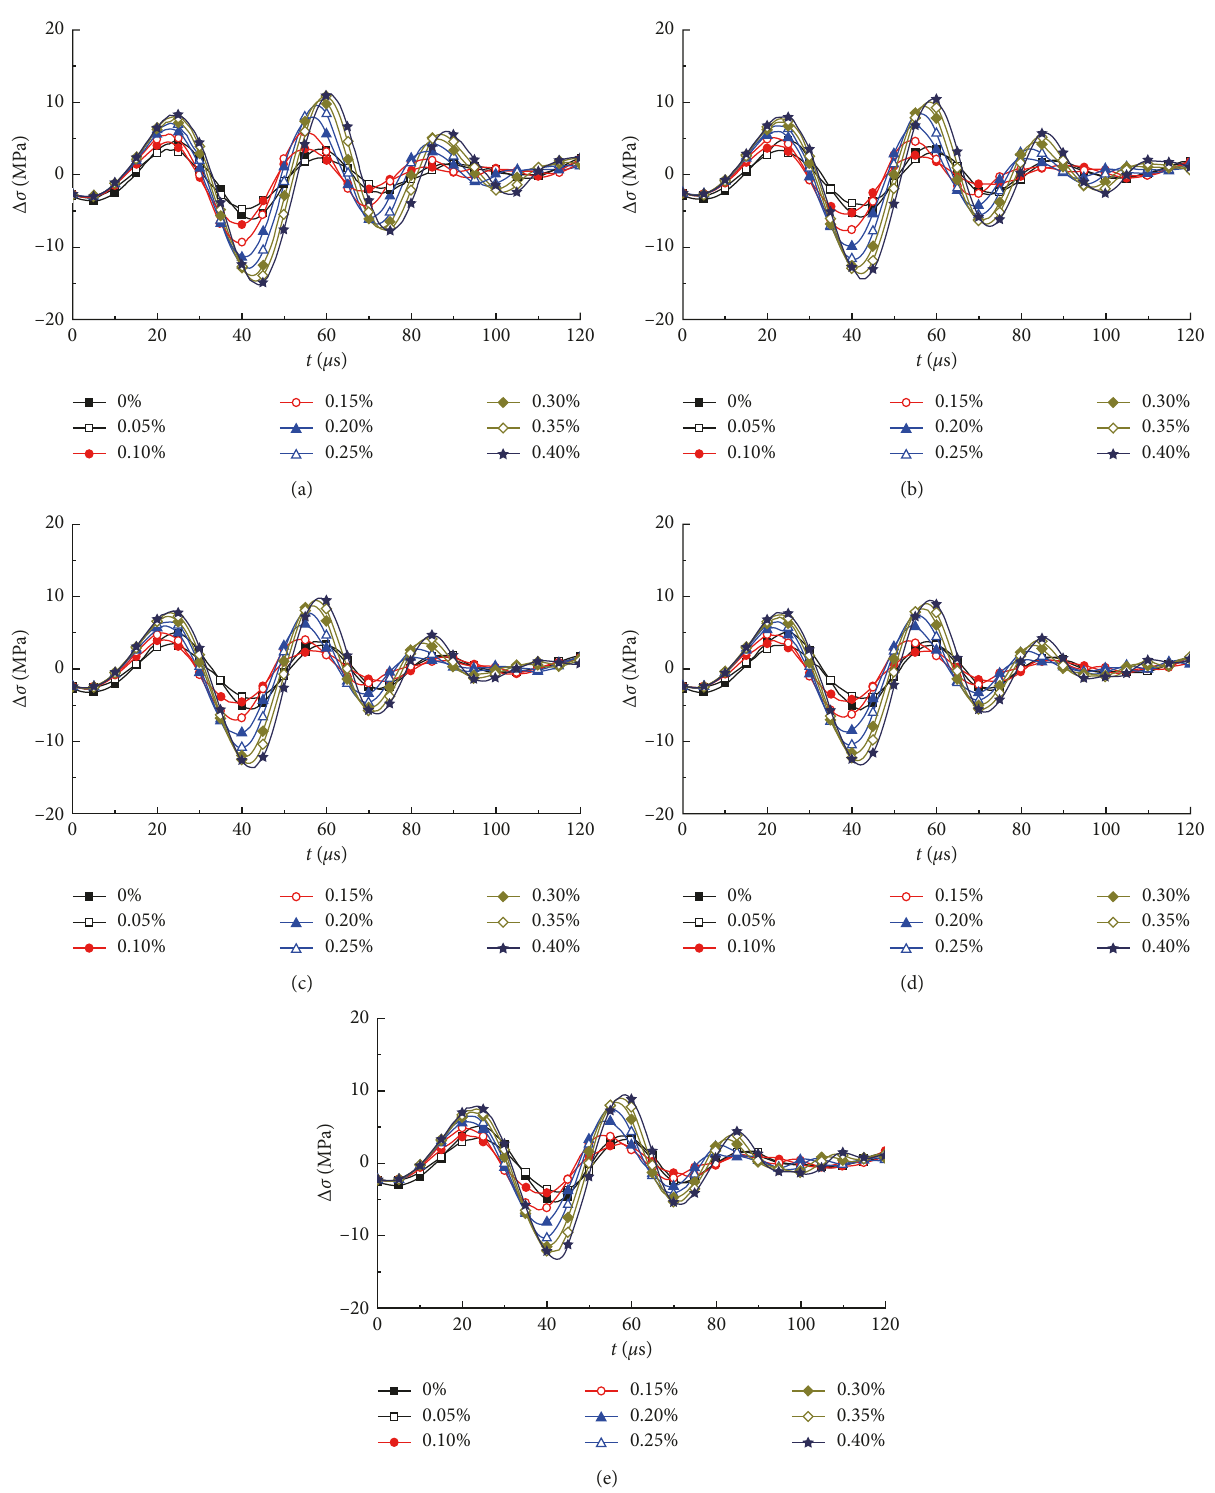
Figure 7: Stress deviation history (c) E 28GPa, (d) E (cid:30)